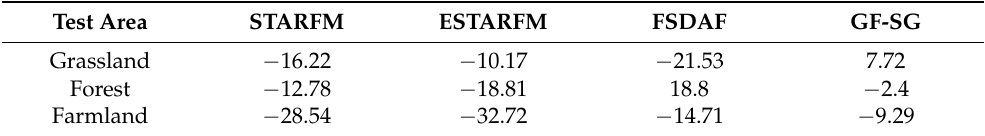
Figure 5. The edge features of the images. ( A – E ) are grassland test areas: ( A ), reference image; ( B – E ) are the results of STARFM, ESTARFM, FSDAF, and GF-SG, respectively. ( F – J ) are forest test areas: ( F ), reference image; ( G – J ) are the results of STARFM, ESTARFM, FSDAF, and GF-SG, respectively. ( K – O ) are farmland test areas: ( K ), reference image; ( L – O ) are the results of STARFM, ESTARFM, FSDAF, and GF-SG, respectively. Table 3. EFRD of fusion images and reference images.